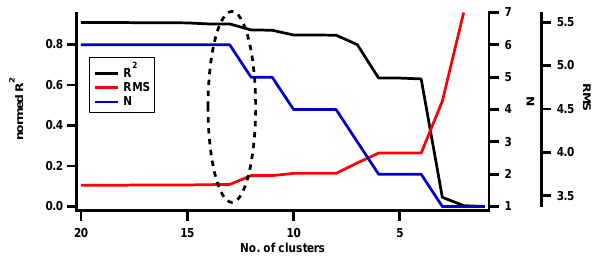
Fig. 4. PSL cluster analysis statistics. The 13-cluster solution was chosen due to the concomitant drop in R 2 and N , and the rise in RMS.